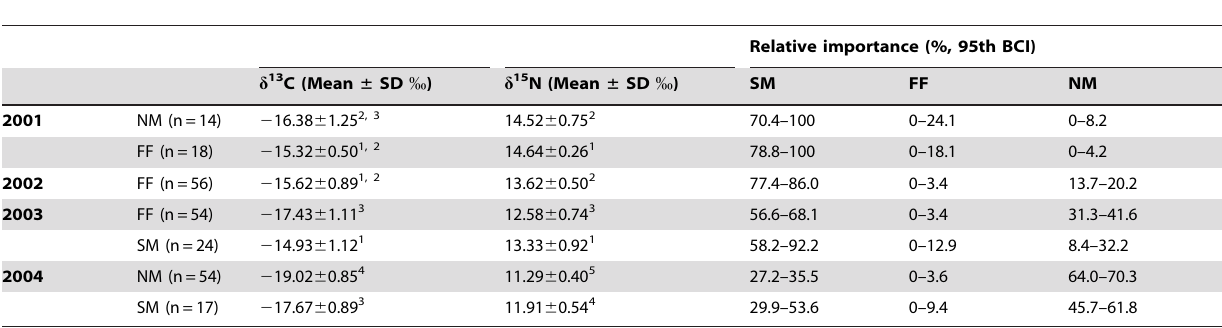
Table 1. Dietary reconstructions of Slender-billed Gull fledglings based on blood d 13 C and d 15 N values.